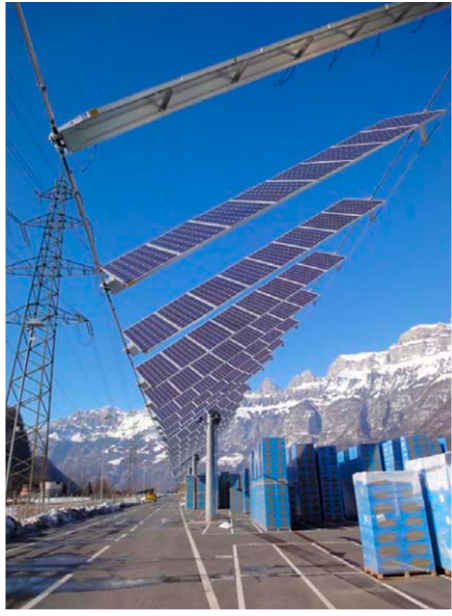
Figure 1. Example of the flexible PV system installation [7].